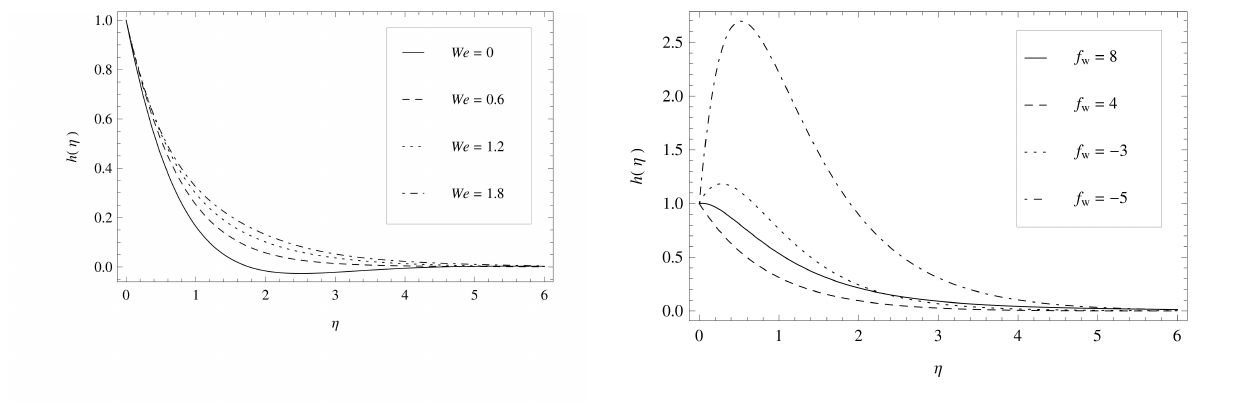
Fig. 21: The influence of a parameter f w on h ( η ) for λ = 0.4, We = 0.8, α = 2, M = 0.7 and (cid:126) = −0.1